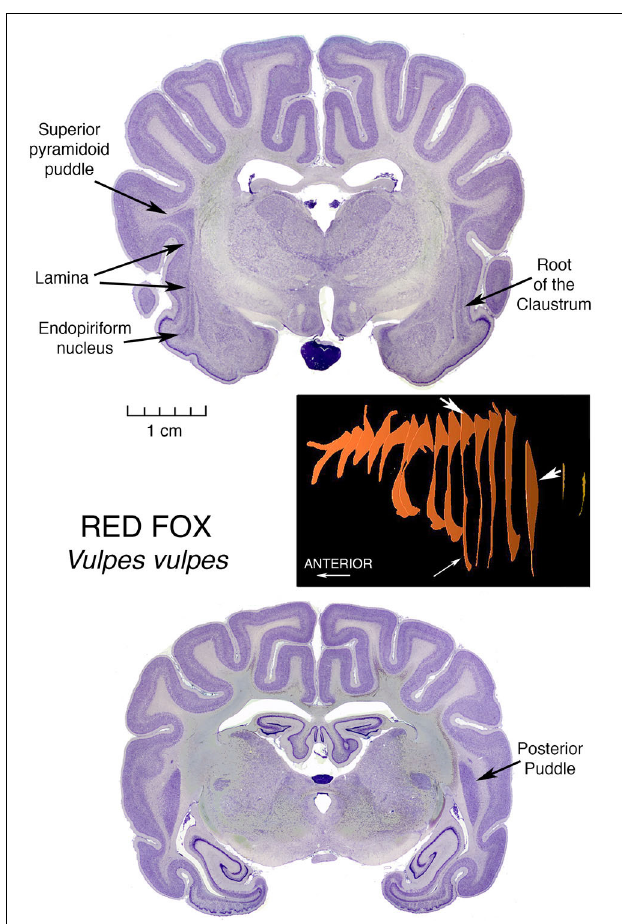
FIGURE 1 | Nissl stained coronal sections through the brain of a Red Fox, illustrating the morphology of the Superior Pyramidoid Puddle, the Root of the Claustrum, the Endopiriform Nucleus and the Posterior Puddle. Accompanying these histological images is a three-dimensional diagram, constructed from outlines of the Claustrum in these sections in series with those of other sections forming an evenly spaced sampling of the entire claustrum. The reconstructions were obtained using the ImageJ program. White arrows on the reconstruction denote the 3-dimensional localization of the features labeled in the section images by black arrows. The specimen in this Figure, as are those in all but the last Figure 7 , is from the Welker Wisconsin Comparative Collection of Mammalian Brains, as scanned and displayed on the website at http://brainmuseum.org.